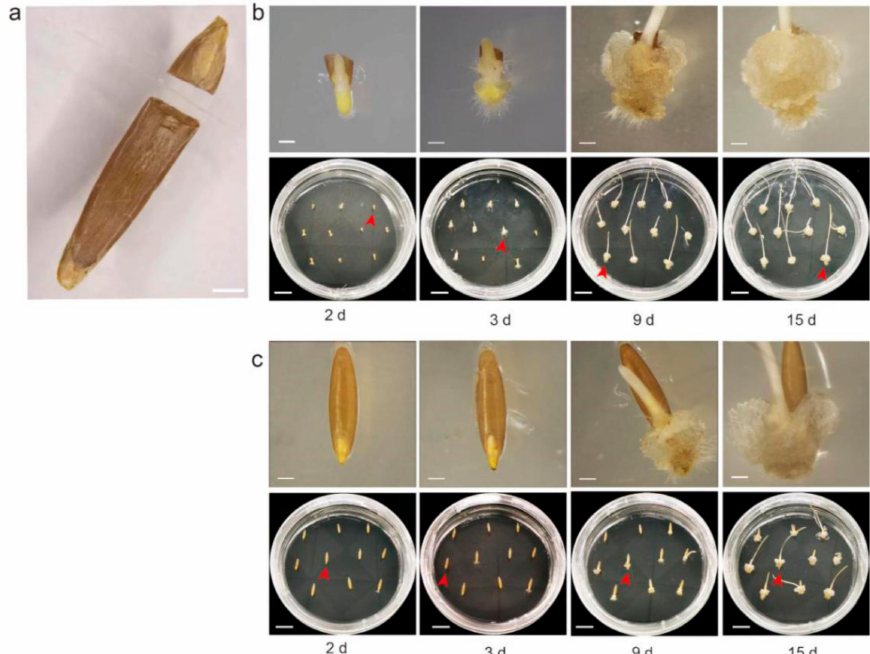
Figure 1. E ff ect of callus induction from mature embryos in Bd21. ( a ). A photograph depicting a sheared seed, scale bars, 1 mm. ( b and c ). The callus induction from sheared seeds ( b ) and untreated seeds ( c ) on di ff erent days. The lower panels in ( b ) or ( c ) show the growth of ten seeds on CIM (callus induction medium)_petri dish (MS + 2.5 mg / L 2,4-D + 0.6 mg / L CuSO 4 + 3 g / L Phytagel), scale bars, 1 cm. The upper panel showed a close-up image of a single seed of the 10 seeds from the corresponding lower petri dish (red arrow), scale bars, 1 mm. For each treatment, three replicates (each of 10 seeds) were